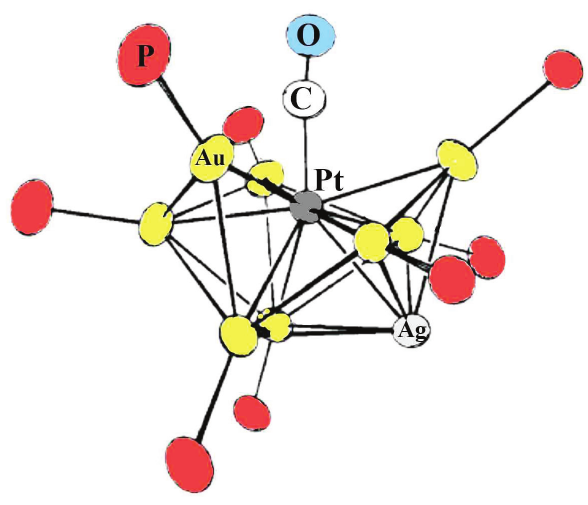
)(AuPPh ) ] 2+ phenyl and nitrate 3 3 8